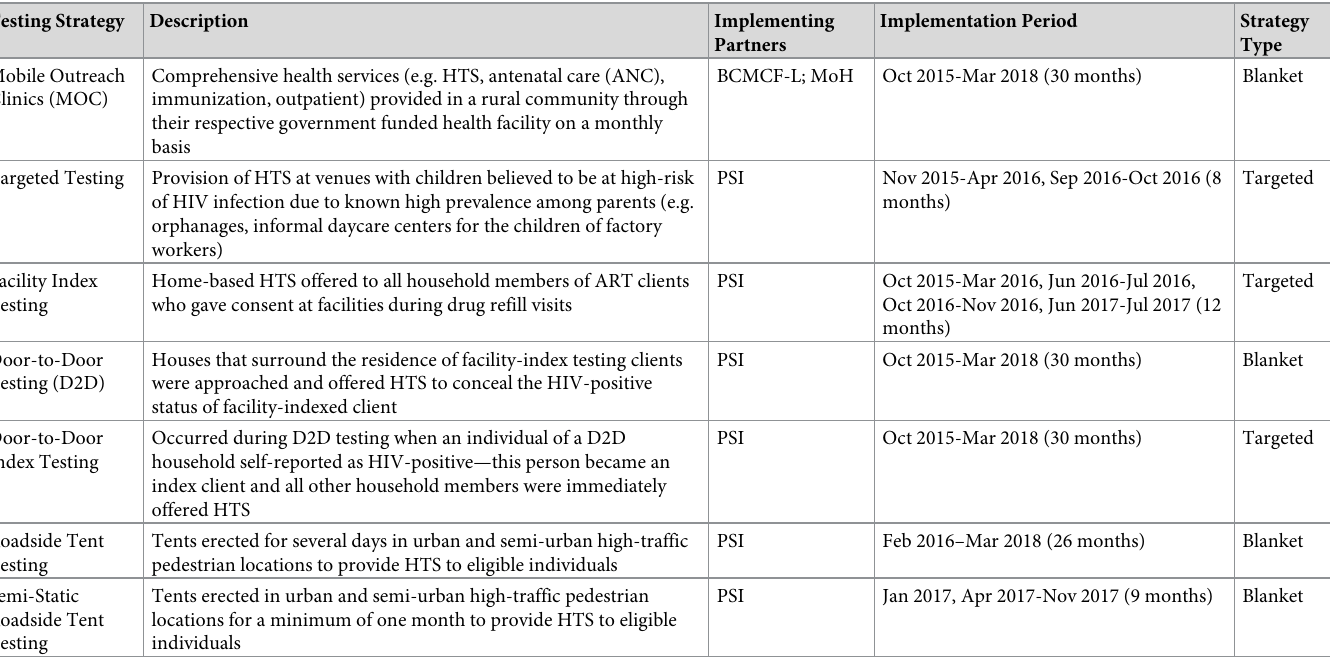
Table 1. Description of community-based testing